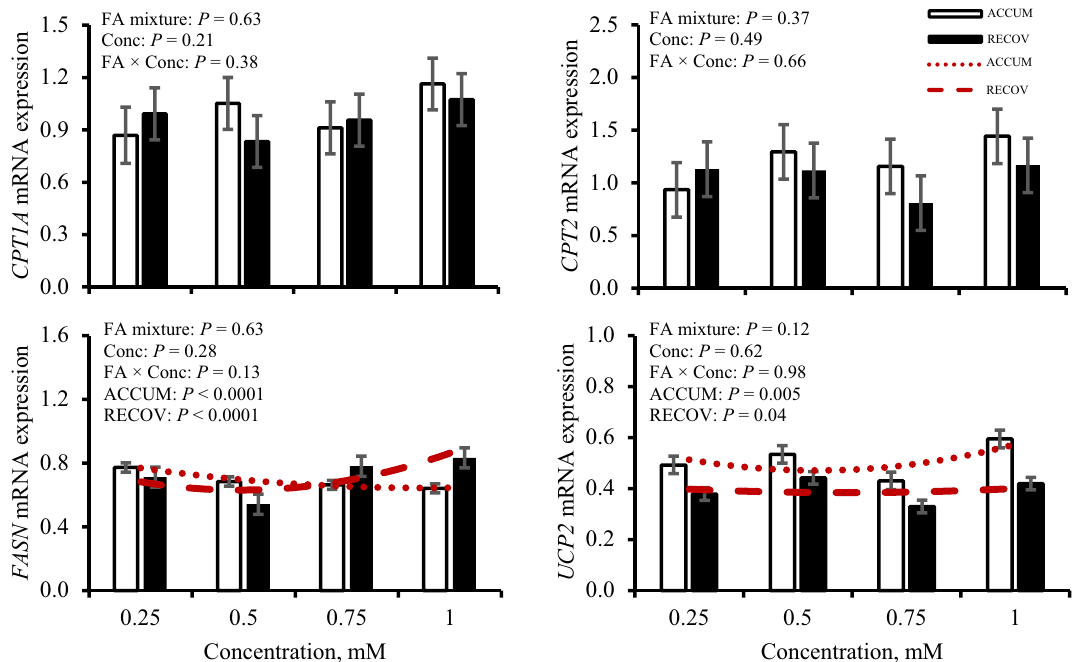
Figure 5. Gene expression of fatty acid-mediated genes carnitine palmitoyltransferase 1A ( CPT1A ), carnitine palmitoyltransferase 2 ( CPT2 ), fatty acid synthase ( FASN ), and uncoupling protein 2 ( UCP2 ) in response to fatty acid mixture representing liver lipid accumulation (ACCUM; open bars and dotted line) and fatty acid mixture representing liver lipid clearing (RECOV; closed bars and dashed line) at different concentrations in primary bovine hepatocytes. Data is presented as least squares mean ± standard error of the means. Quadratic relationships are displayed if P ≤ 0.15 for a main